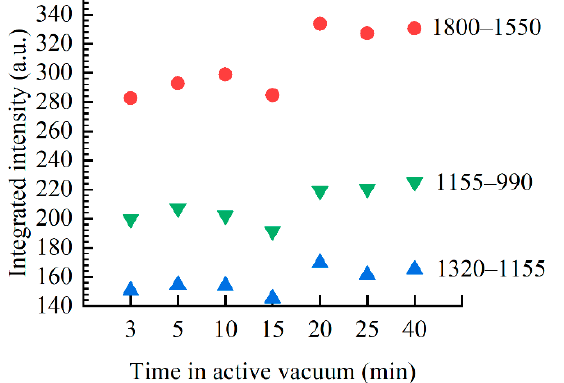
Figure 2. Integrated intensity as a function of time in active vacuum for three distinct spectral regions: the base region from 1800 to 1550 cm − 1 (red circles), asymmetric phosphate vibration from 1320 to 1155 cm − 1 (blue upright triangles) and symmetric phosphate region from 1155 to 990 cm − 1 (inverted green triangles). The increased integrated intensity of the 2040 min films compared to the 3–15 min films indicates hydration-related changes in thin films for all three regions rather than conformational changes.